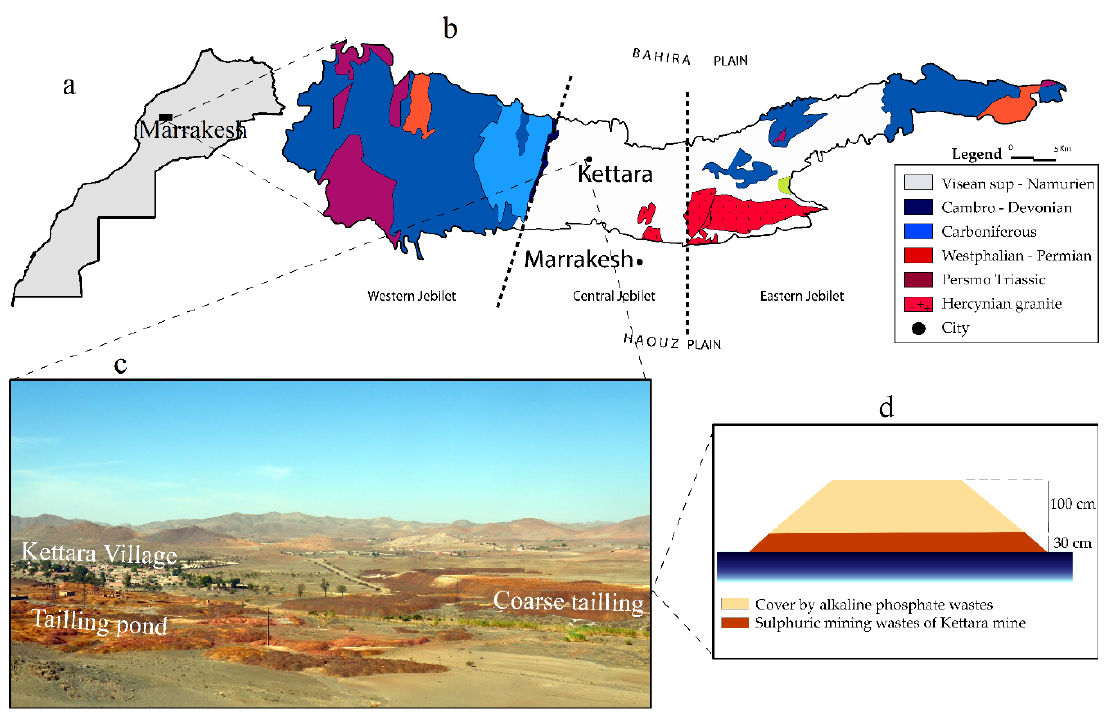
Figure 1. The localization of the abandoned mine of Kettara ( a , b ), tailing impoundment area ( c ), and the store-and-release cover design at the experimental park ( d ) (modified from Boss é et al.